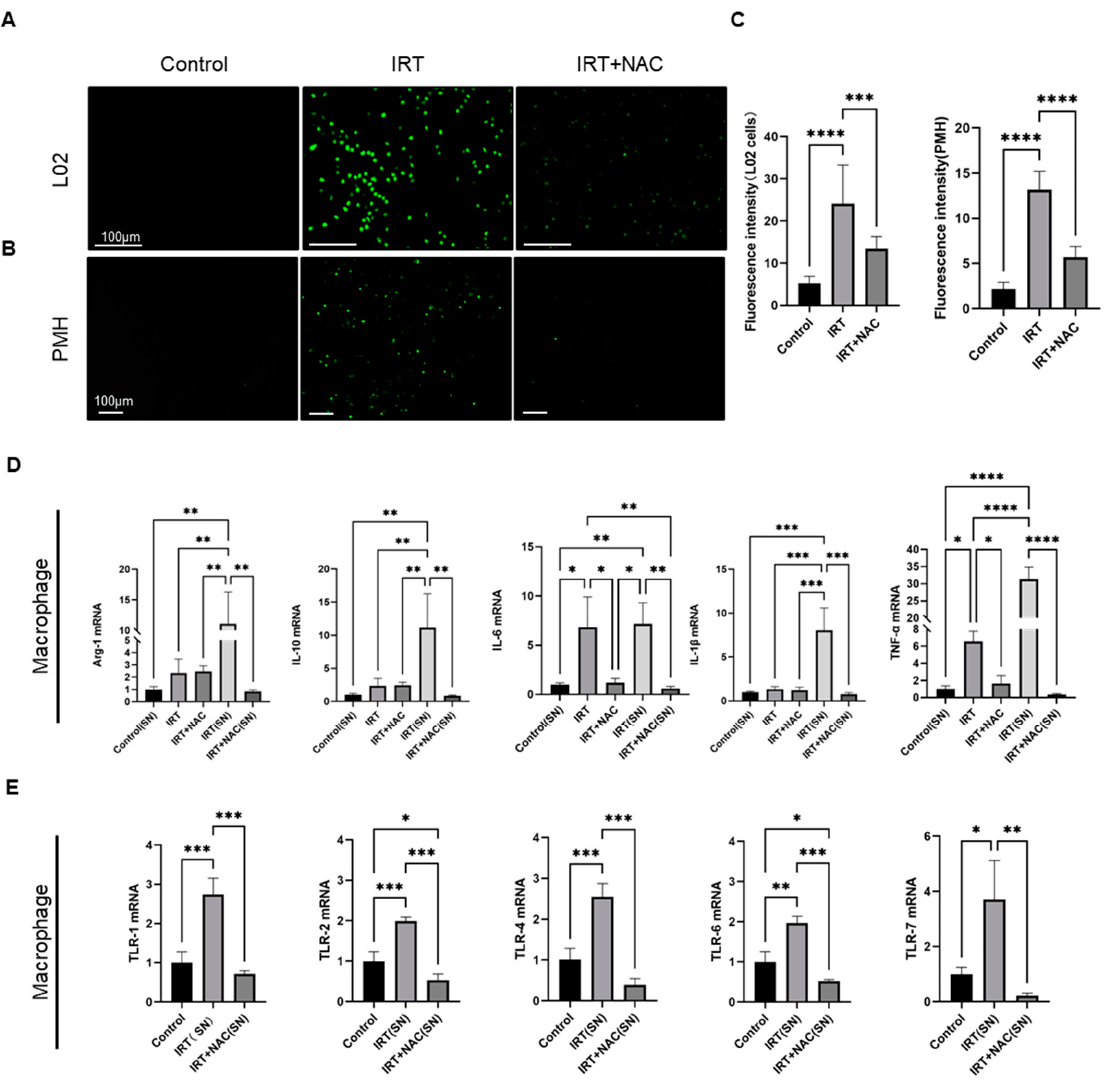
Figure 5. Irinotecan activates macrophages and TLRs family expression through ROS production in hepatocytes. L02 or primary mouse hepatocytes (PMH) were treated with irinotecan (6 µ M and 10 µ M, respectively) in the absence or presence of NAC (600 µ M) for 24 h, and the changes of intracellular ROS content were detected, and the supernatant was transferred to macrophages and continued to be cultured for 24 h, and the total RNA of macrophages was extracted for subsequent qPCR experiments. Determination of ROS activity in L02 ( A ) and PMH cells ( B ) after irinotecan and NAC treatment. ( C ) Quantitative analysis of fluorescence intensity of reactive oxygen species in L02 cells and PMH after treatment with irinotecan and NAC. ( D ) Changes in mRNA levels of Arg-1, IL-10, IL-6, IL-1 β , and TNF- α in the control (SN) group, the irinotecan direct treatment group, the irinotecan (SN) treatment group, the irinotecan and NAC direct treatment group, and the irinotecan and NAC (SN) treatment group. ( E ) Changes in mRNA levels of the TLR family in macrophages treated with supernatants from primary hepatocytes treated with irinotecan (10 µ M) in absence or presence of NAC (600 µ M). Data are reported as mean ± SD, and each graph is representative of at least three independent experiments. Statistical significance was tested with an unpaired t -test